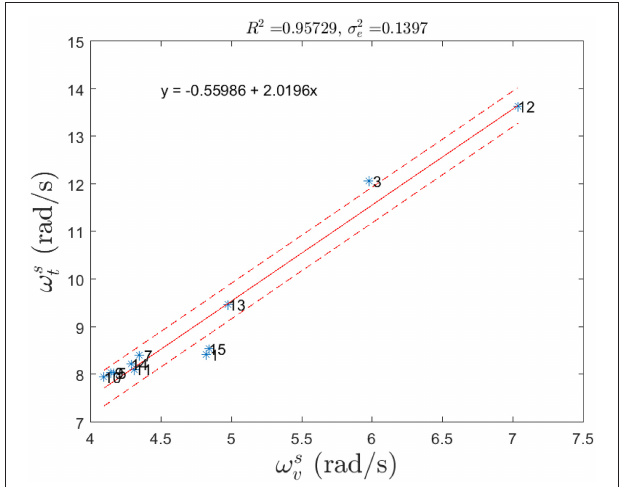
FIGURE 14 | Measured TA frequencies (*), empirical formula (solid line) and standard deviation of prediction error (dashed) along with the formula.